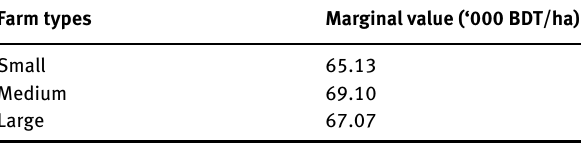
Table 5: Marginal value of land in different types of farms Farm types